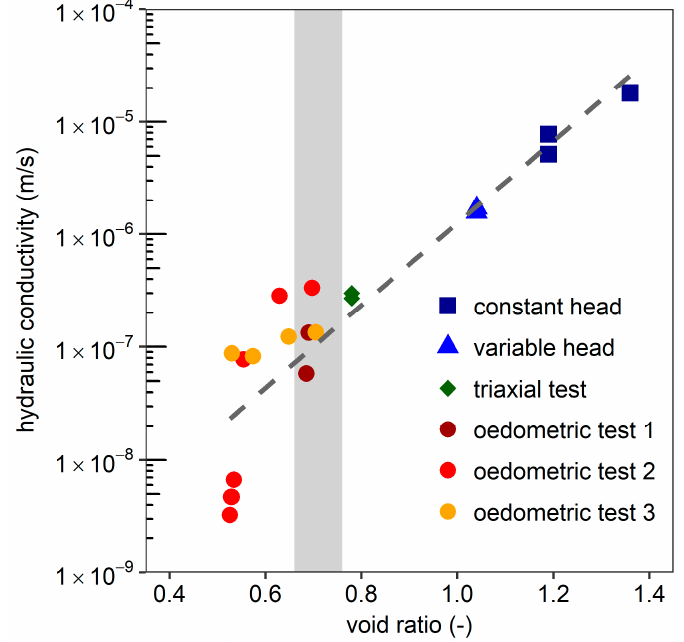
Figure 8. Saturated hydraulic conductivity for different void ratios obtained by different laboratory tests. Dashed line shows the best-fit relation. Grey shaded area represents the expected void ratio in the embankment.